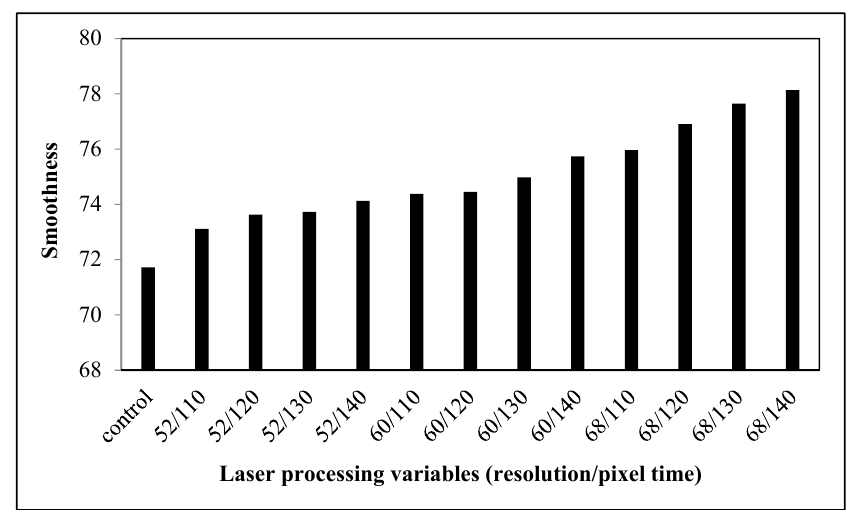
Figure 3. Relationship between laser processing variables and the smoothness of cotton fabric.